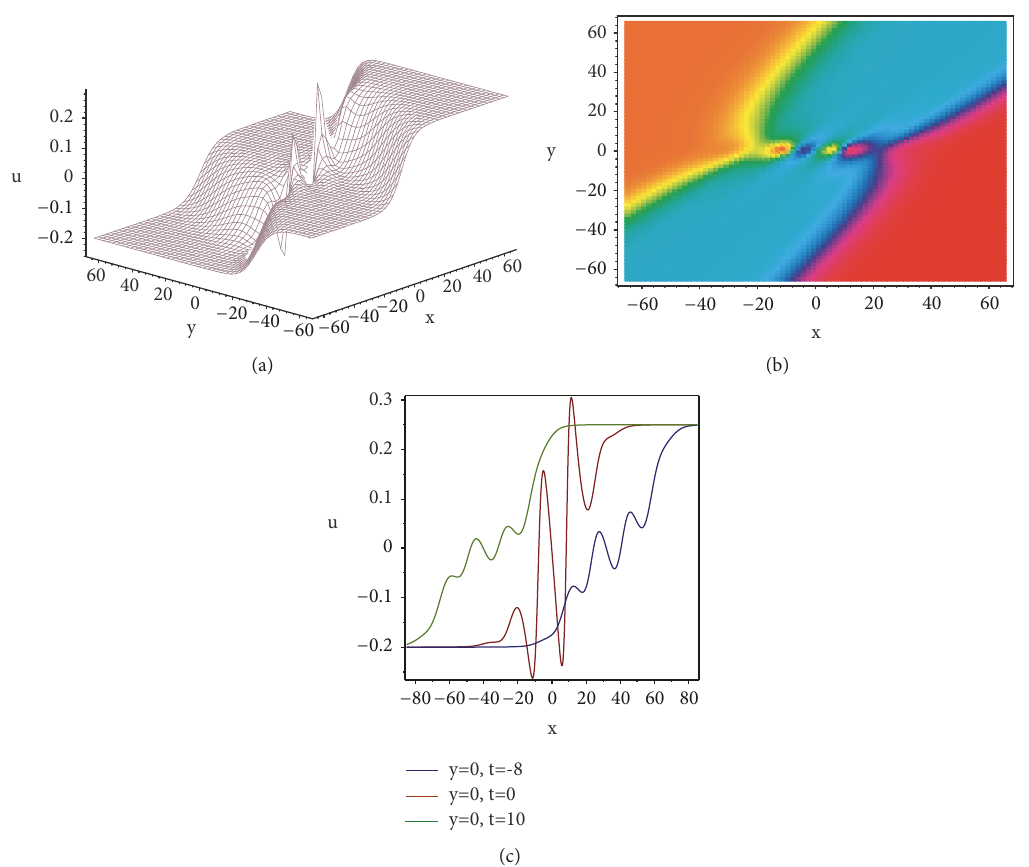
Figure 4: Profile of the interaction among a lump, triangular periodic waves, and two-kink soliton in (37). (a) 3-dimensional plot with 𝑡 = 0 , (b) the corresponding density plot, and (c) the curve plot at various values of